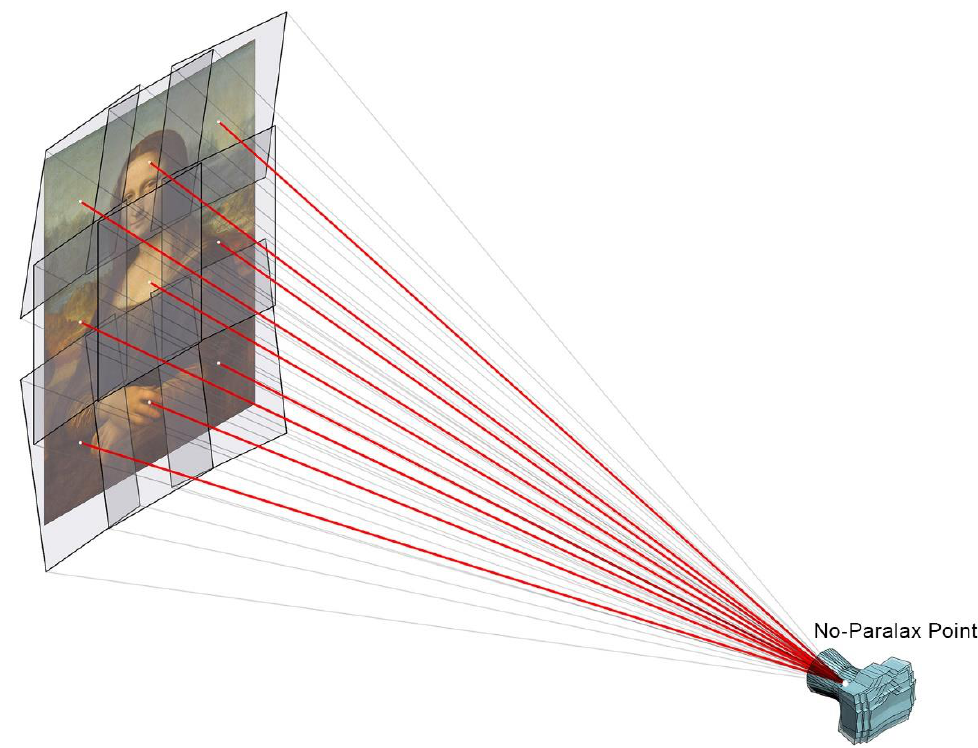
Figure 6. Single-viewpoint capture technique. The camera is rotated around its no-parallax point.